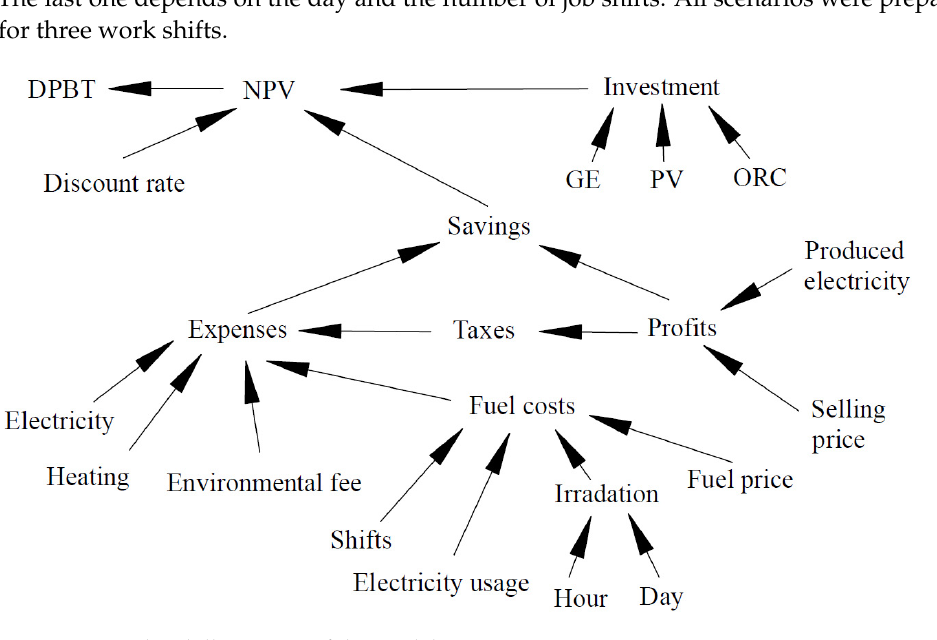
Figure 4. Graphical illustration of the model.